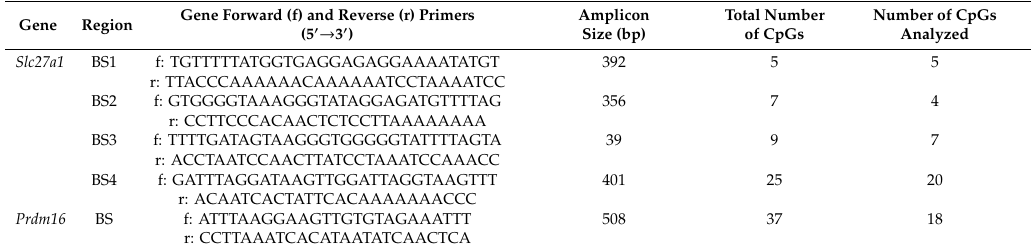
Table 1. Bisulfite-specific primers for analyzed DNA regions of Slc27a1 and Prdm16 genes. Gene